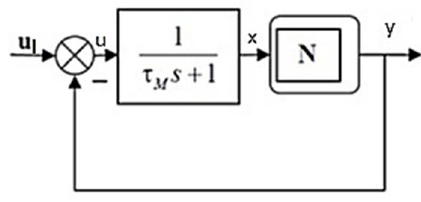
Figure 4. PWPF system for roll control.